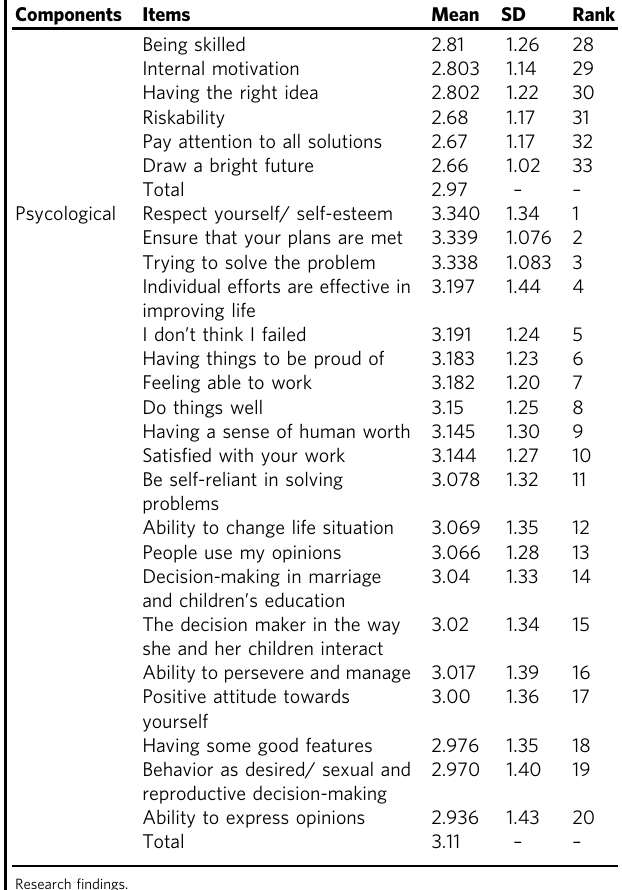
Table 4 The ranking of the components of